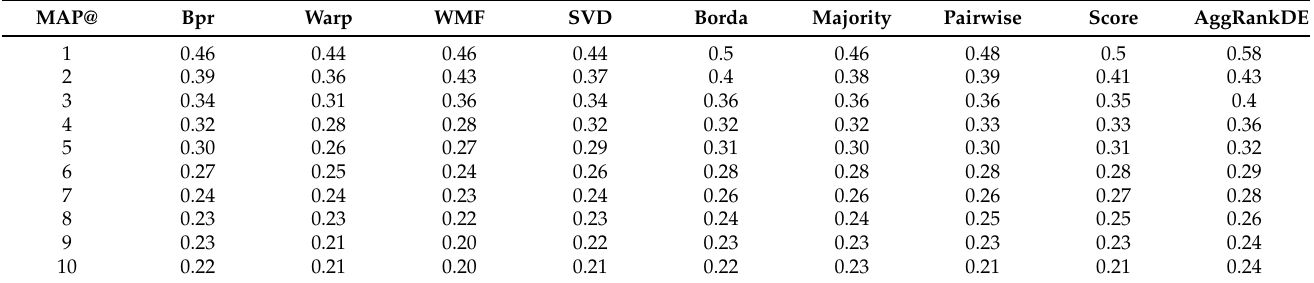
Table 8. The quality of the generated recommendations (MAP) for different MAP @ values for the best parameters presented in Table 1.